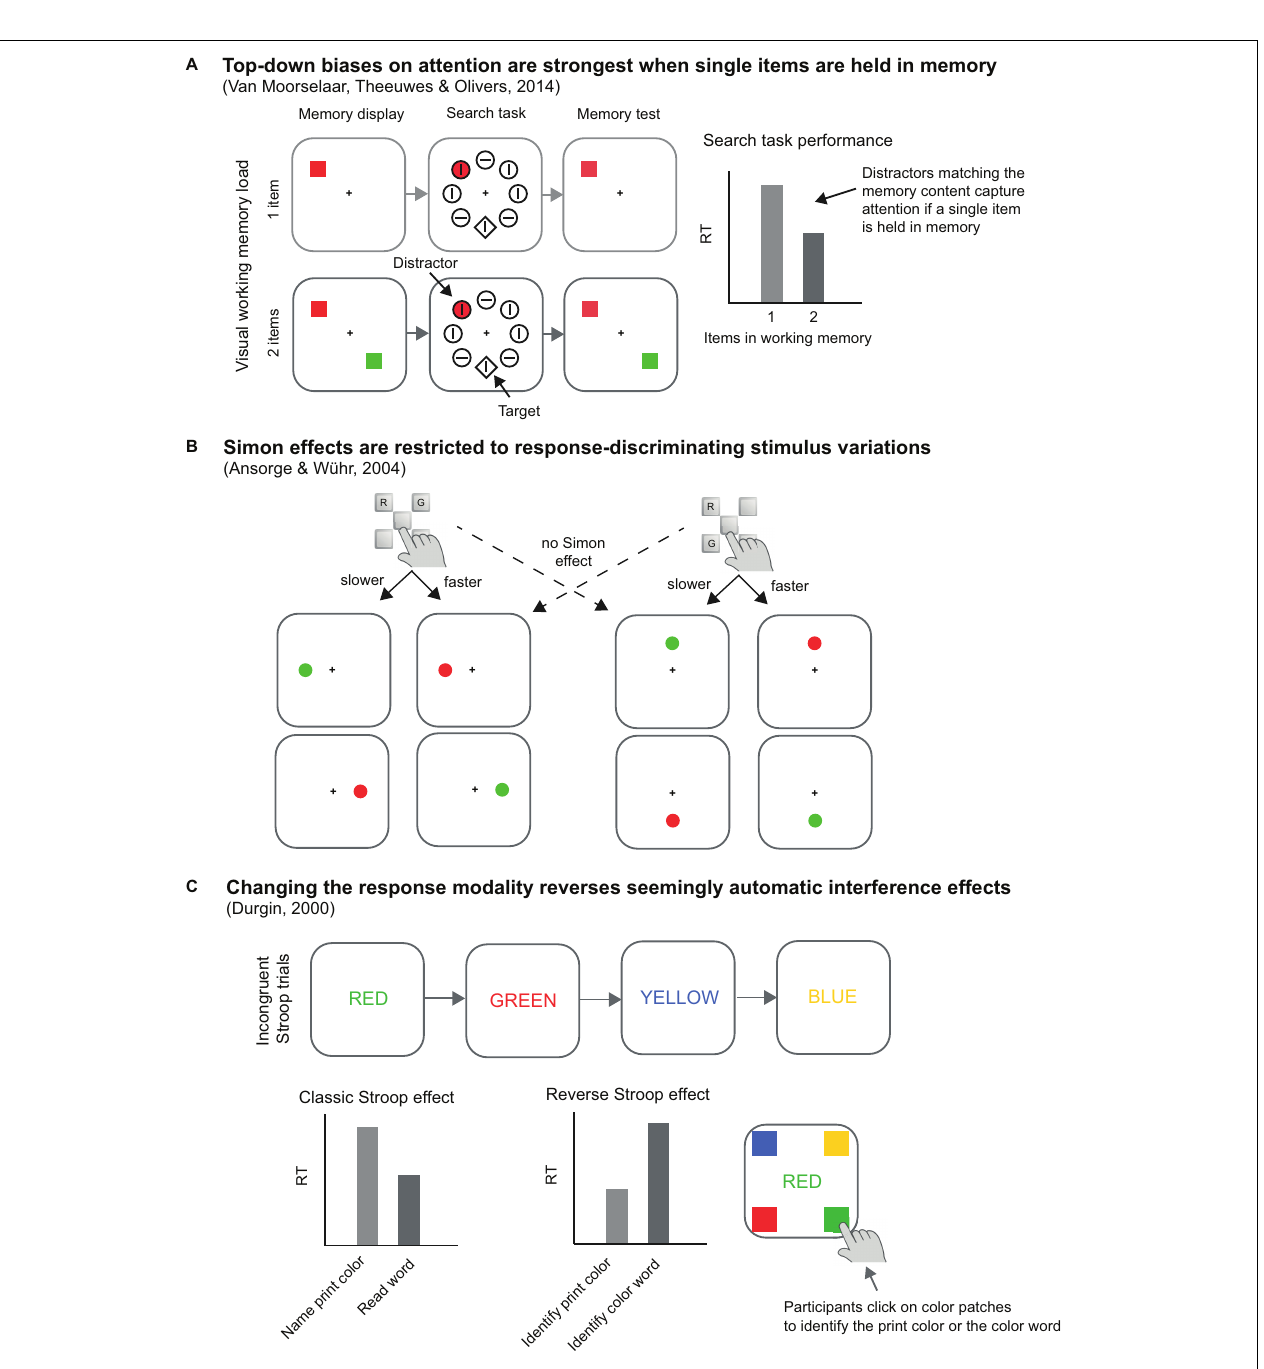
FIGURE 2 | Examples of empirical results that challenge a rigid limited resources view. (A) Top-down biases on attention are strongest when single items are held in memory. Related to the results of Büsel et al. (2019) described in the main text, the results of Van Moorselaar et al. (2014) illustrate that attention is captured by distractors that match the working memory content only if a single color is kept in memory, but this capture effect already vanishes if two colors are kept in working memory, even though this should not exceed generally assumed capacity limits. (B) Ansorge and Wühr (2004) found out that Simon effects are restricted to response-discriminating stimulus variations. The key mapping, that is, whether the alternative response keys for red (R) or green (G) stimuli were arranged in a horizontal or a vertical configuration varied between participants and red and green target stimuli occurred either along the horizontal or vertical meridian. Crucially, spatial stimulus-response compatibility effects (Simon effects) – facilitation for responses that shared location codes with targets (e.g., right responses to right targets) relative to responses and targets of different locations (e.g., right responses to left targets) – occurred only in those conditions where the axis of stimulus variations corresponded with the spatial response axis. The same compatibility effects were missing with regards to the non-varying spatial response axis, suggesting that location selection reflected response monitoring rather than response execution. (C) Changing the response modality reverses seemingly automatic interference effects. Durgin (2000) reversed the Stroop effect simply by asking participants to click on color patches corresponding to the word meaning rather than utter the print color names. For further discussion see main text.